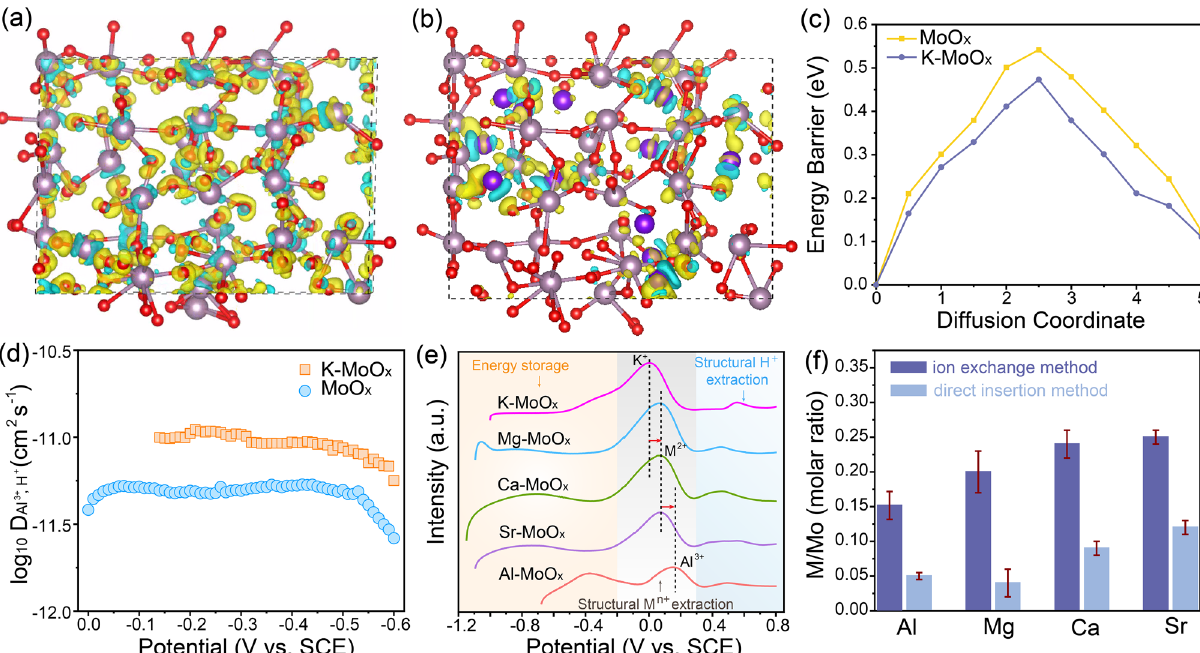
Fig. 2 Ion-exchange mechanism and applicability. Differential charge density of a MoO x and b K-MoO x. (The value of the isosurface is 0.005 e Å −3 .) The yellow and blue regions refer to electronic charge accumulation and depletion. The gray, red and purple balls refer to Mo, O and K atoms, respectively. c Comparison of diffusion energy barrier curves for Al ion in MoO x and K-MoO x . d The corresponding Al 3+ and H. + diffu- sion coefficients of K-MoO x and MoO x . e LSV curves of structural cation extraction for M-MoO x (M = Al, Mg, Ca, Sr and K). f ICP-OES results of M-MoO x by ion-exchange and direct insertion methods (M = Al, Mg, Ca and